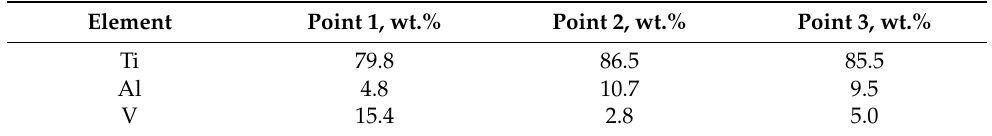
Figure 6. Bright- ( a , b ) and dark-field TEM images ( c ) and the associated SAED pattern with indexing scheme ( d ) of the microstructures of the EBAM Ti-6Al-4V samples produced without substrate cooling. Dashed red line box in ( a ) highlights the area that is enlarged in ( b , c ). The dark-field TEM micrograph was obtained with the 012(cid:3435)142(cid:3439) α -Ti reflection ( d ). The microstructure was obtained at a distance of 40 mm from the substrate. Table 3. Elemental compositions of the EBAM Ti-6Al-4V samples produced without substrate cooling. EDX data were obtained at the points indicated in Figure 6a.